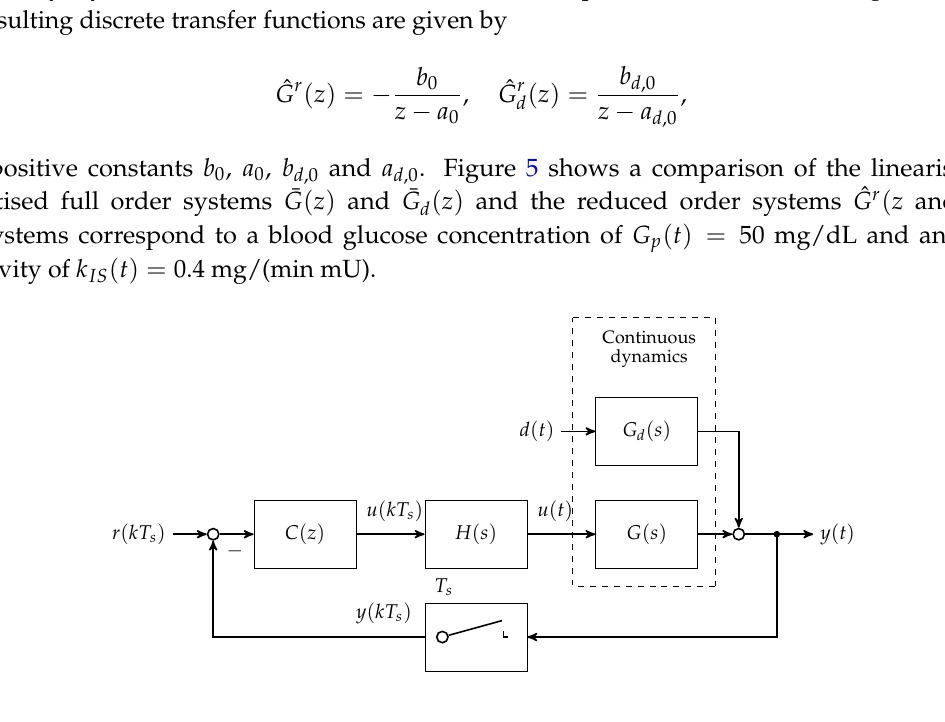
Figure 4. Block diagram of the discrete disturbance rejection controller C ( z ) with hold transfer function H ( s ) and δ -sampler in the feedback